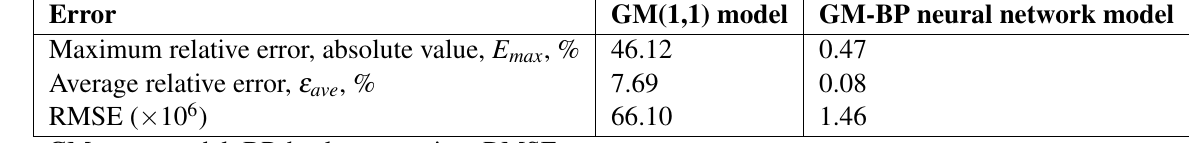
Table 1 Calculation results of the evaluation indexes of each model.